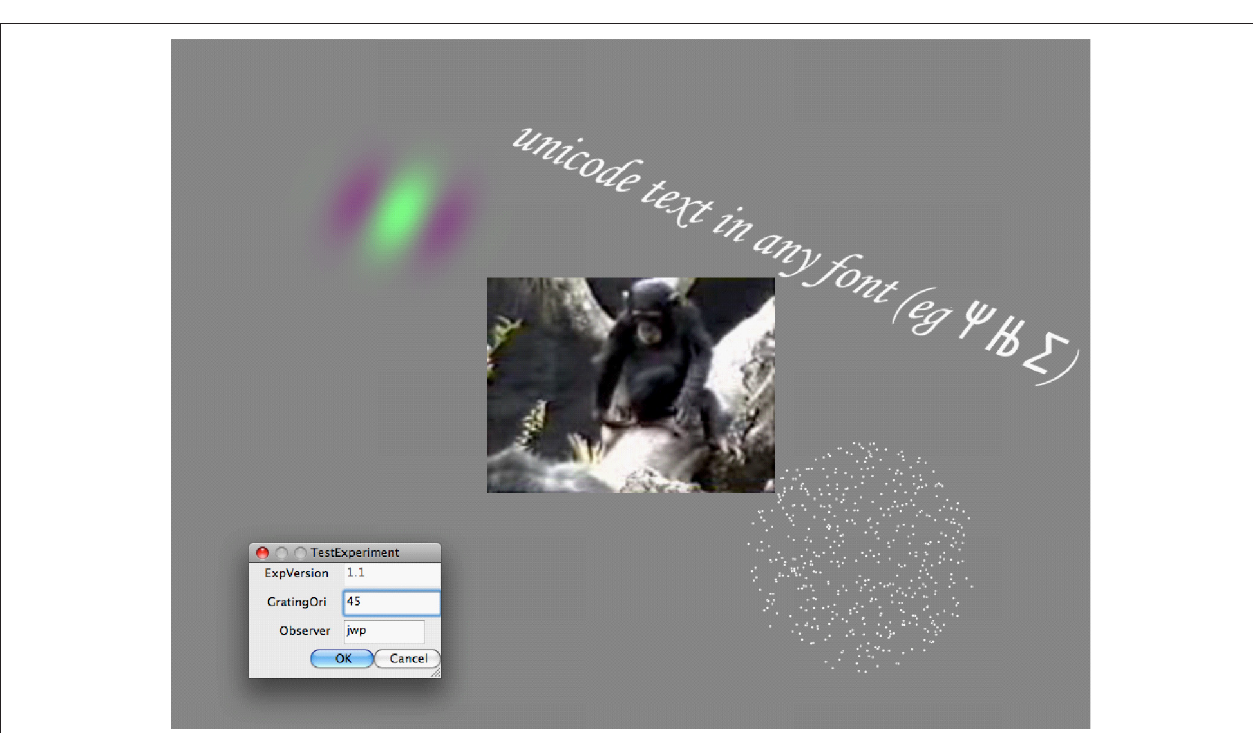
All the stimuli are dynamic and being updated simultaneously at 60Hz, without any dropped frames. Also shown is a dialog ( gui.DlgFromDict ) to receive information about the current